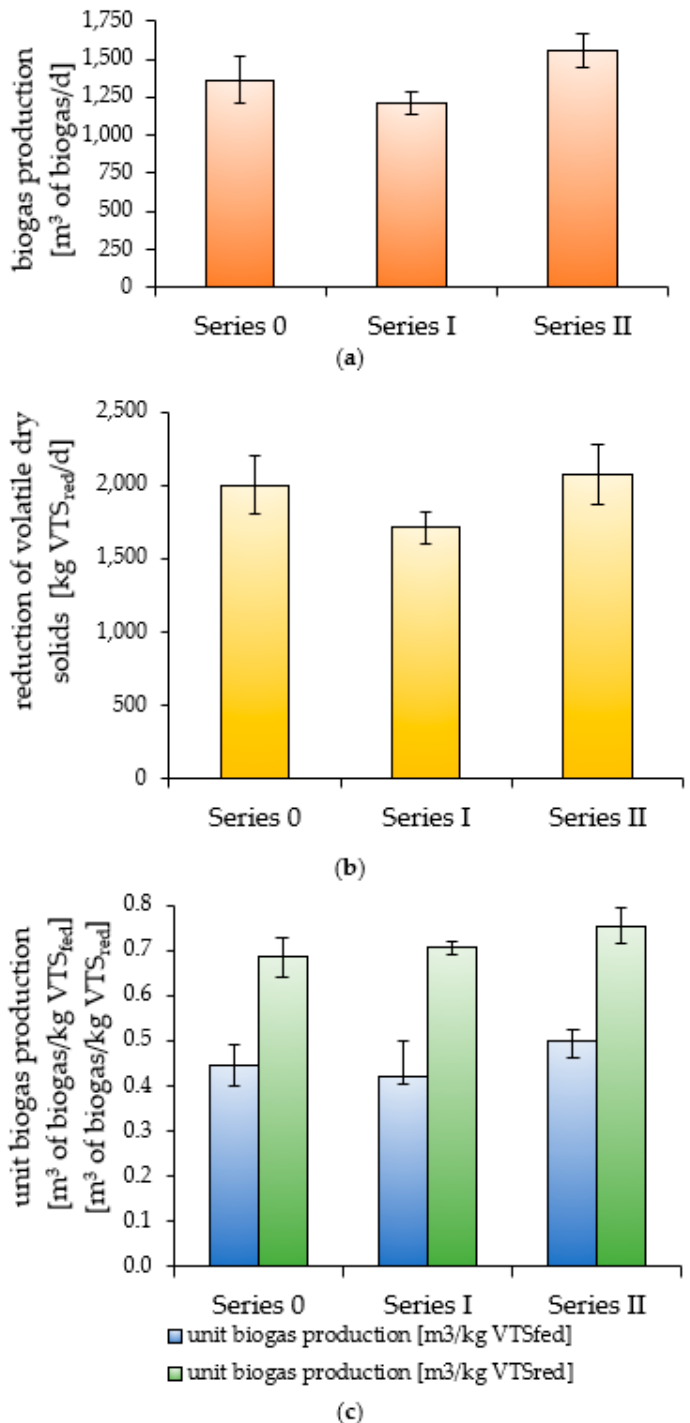
Figure 5. Biogas production ( a ), reduction of volatile total solids ( b ) and unit biogas production ( c ) in each series of the